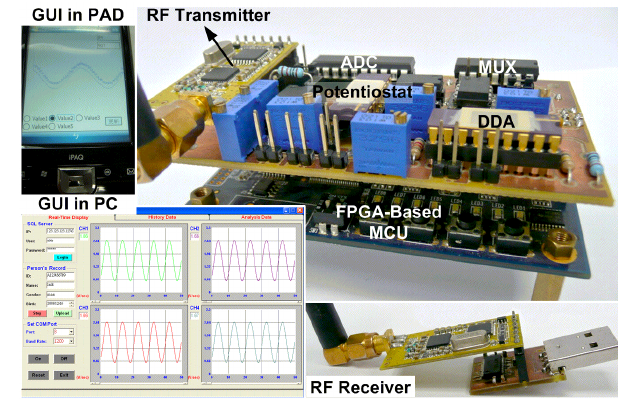
Figure 14. Photograph of the proposed system.